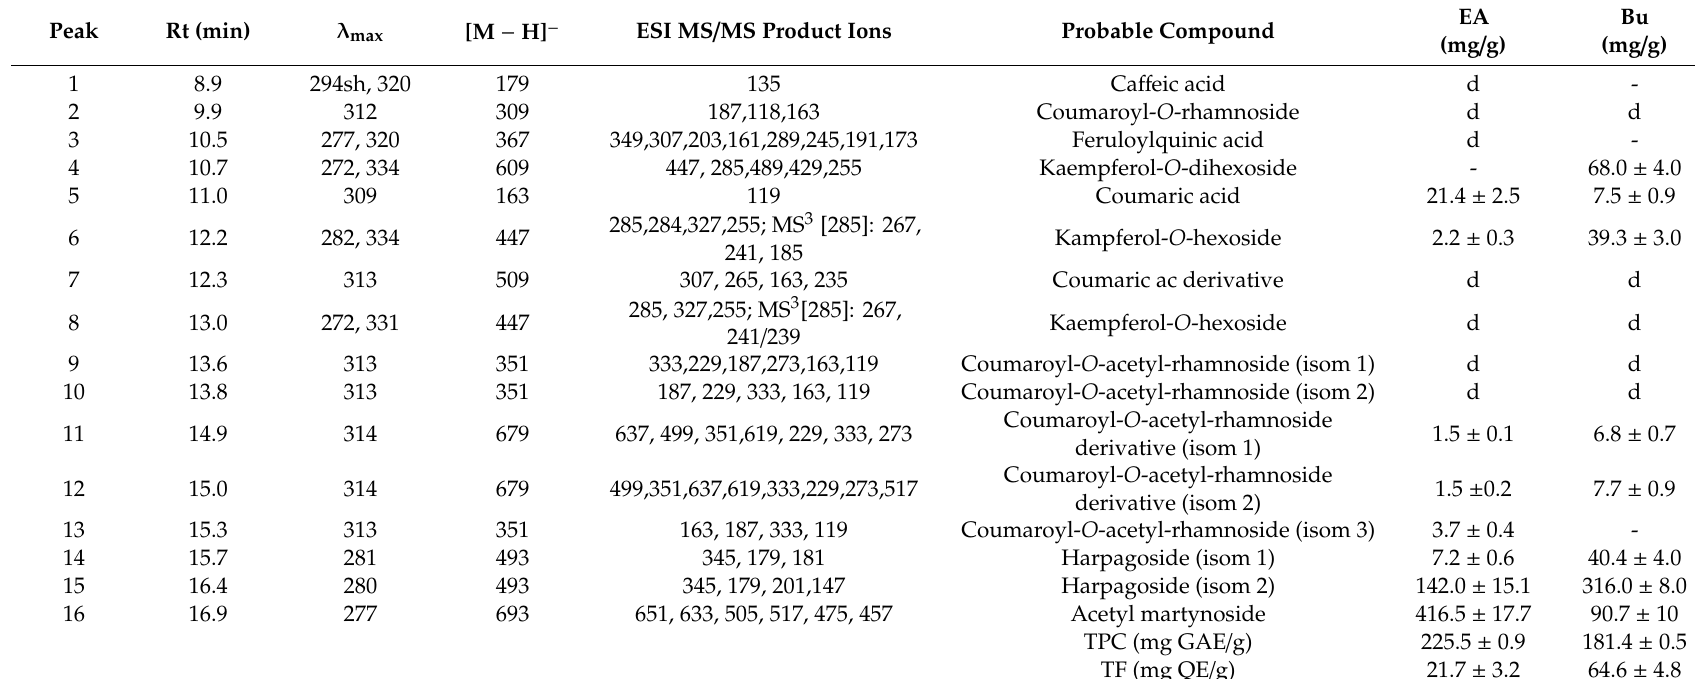
Table 1. Phenolic compounds of S. tenuipes EA and Bu